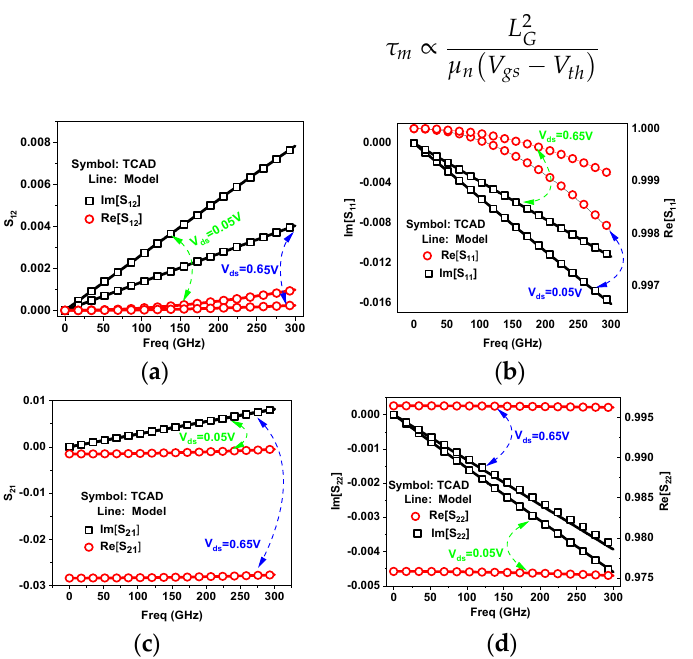
Figure 9. Comparison between TCAD-simulated and -modeled S-parameters under V gs = 0.65 V, V ds = 0.05 V and V gs = 0.65 V, V ds = 0.65 V. ( a ) S12, ( b ) S11, ( c ) S21 and ( d ) S22.